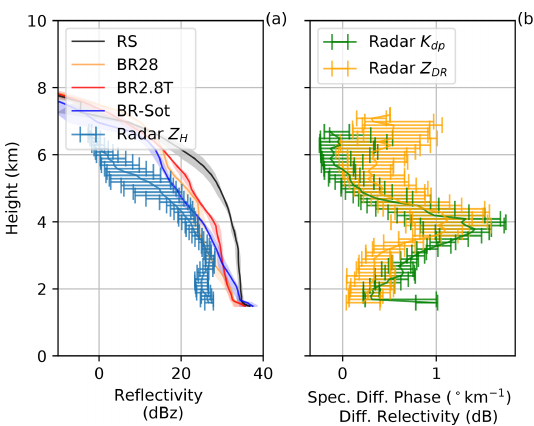
Figure 5. Vertical profiles of the (a) horizontal reflectivity ( Z H ), (b) specific differential phase ( K dp ) and differential reflectivity ( Z DR ). The solid lines are the mean, with shaded areas and error bars showing the 10th and 90th percentiles for the model simula- tions and Doppler radar, respectively, at 15:30UTC.